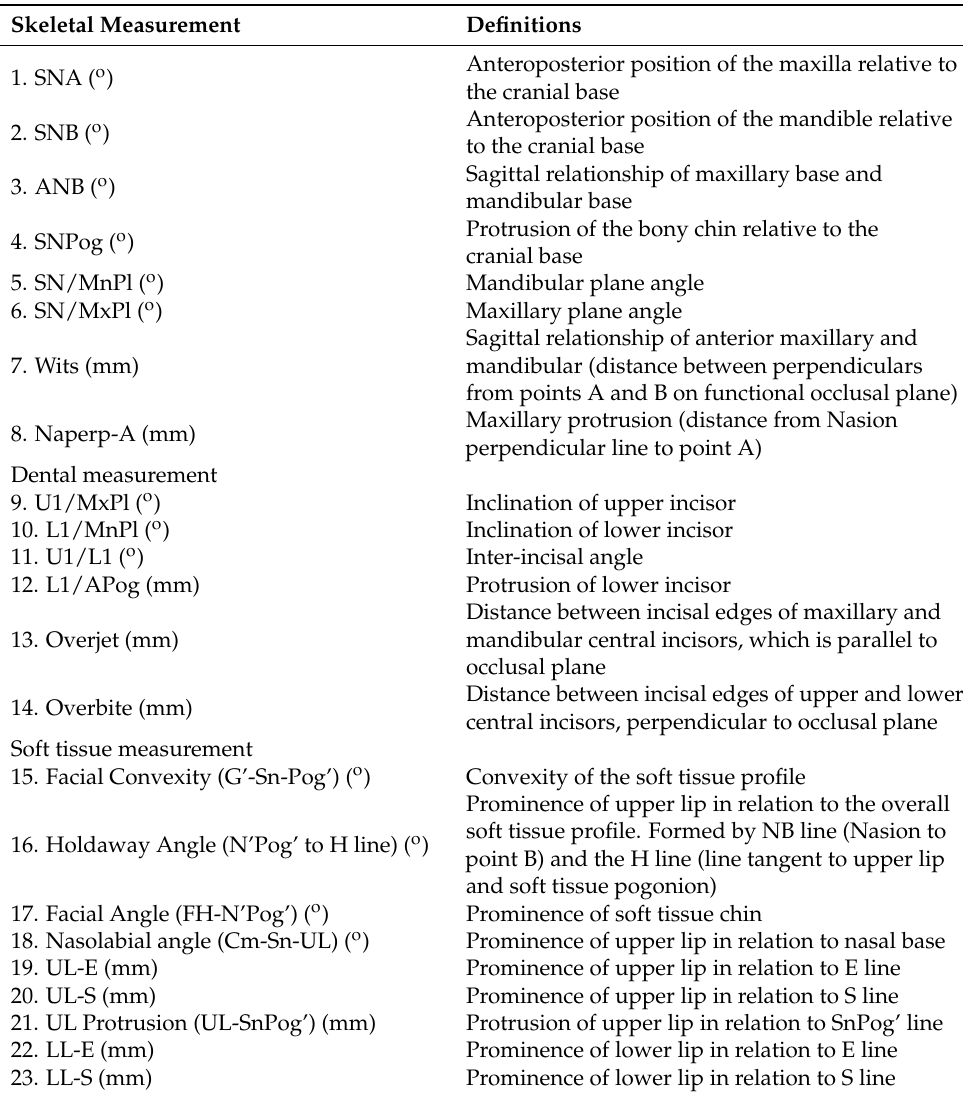
Table 1. Definitions of skeletal, dental, and soft tissue